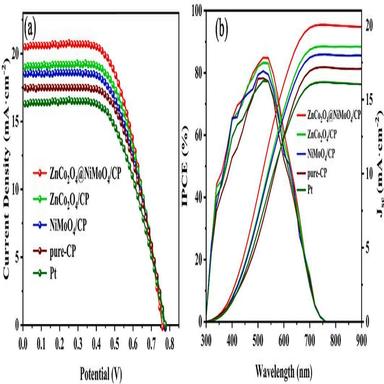
(a) J-V curves of DSSCs based on different CEs; (b) different CEs' IPCE spectrum and Jsc.